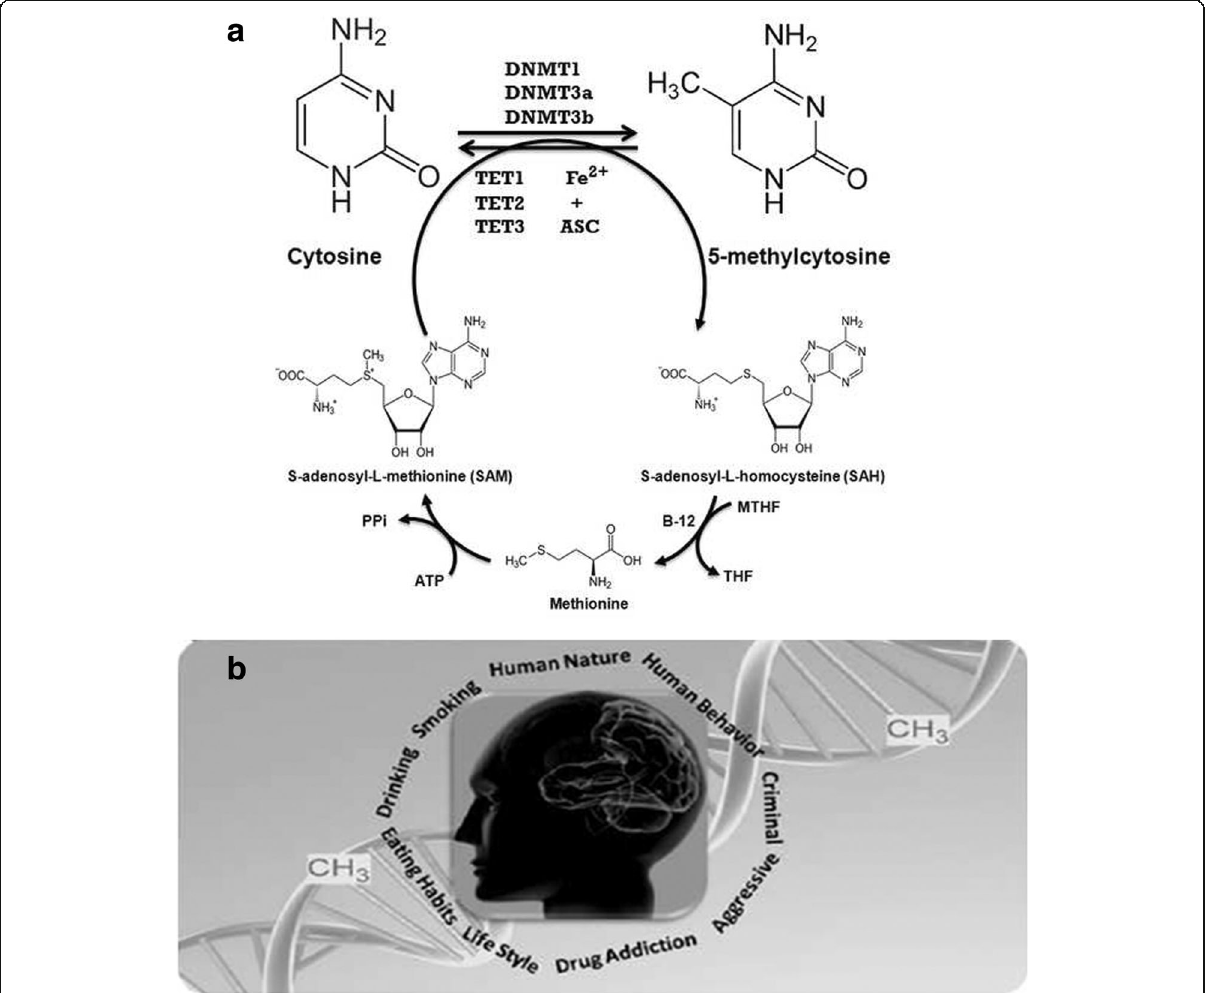
Fig. 1 DNA methylation dynamics and human phenotypic variations. a In humans, three different DNA methyltransferases (DNMT1, DNMT3a, and DNMT3b) are responsible for methylating the genomic DNA (primary substrate) at the 5 ’ position of the cytosine residue. The methyl group donor is S-adenosyl-L-methionine (SAM, also called cofactor or secondary substrate) which is oxidized to S-adenosyl-L-homocysteine (SAH) after donating the methyl group. In the genome, the methyl groups of cytosine residues are removed by ten-eleven translocation proteins (TET1, TET2, TET3) which use Fe 2+ and ascorbate as additional cofactors. In a separate reaction system inside the cells, SAH is reduced to methionine using cofactor 5-methyl-tetrahydrofolate (MTHF), and the methionine is converted back to universal methyl donor SAM using an ATP molecule. b DNA methylation profile of human tissues/cells is affected by its immediate environment and activities such as lifestyle, eating habits, alcoholism, smoking, diseased, aggressive, drug addiction, perpetual criminal commitment, etc. The combined effect of the geographical location and the personal experiences/behaviors of individuals which are usually repetitive in nature leave behind certain methylation marks on their